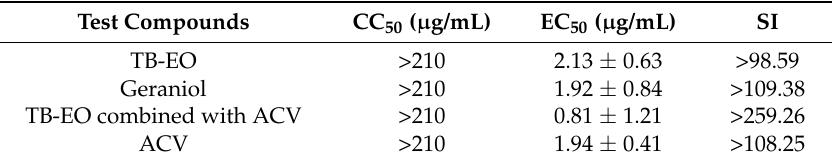
Table 4. Antiviral activity of TB-EO, geraniol, and TB-EO with ACV in combination against HSV-2